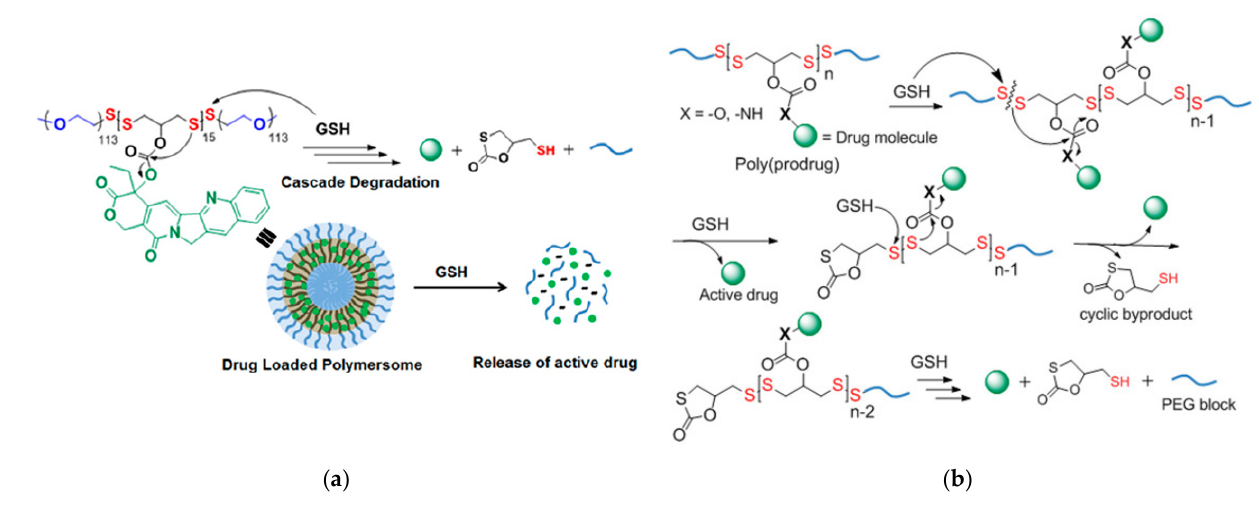
Figure 21. ( a ) GSH-induced cascade degradation of polydisulfide-CPT polymersomes. ( b ) Proposed mechanism for the degradation of polydisulfide-CPT by GSH. Adapted with permission from [118]. Copyright (2019) American Chemical Society.